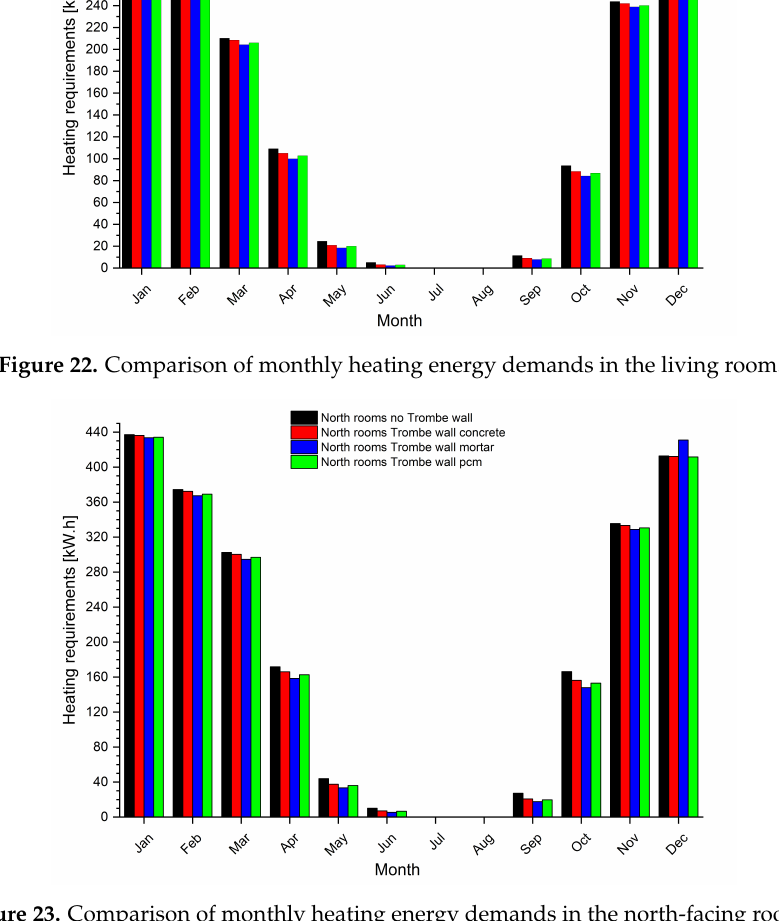
Figure 23. Comparison of monthly heating energy demands in the north-facing